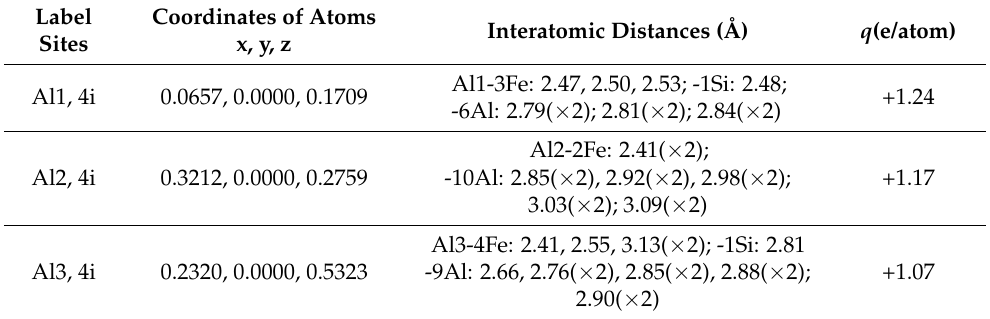
Figure 2. Schematic structure of θ -Al 68 Cu 2 Si 8 Fe 24 along its [010] projection ( a ). The schematic coordination of Cu ( b ) and Si ( c ) is shown, respectively. The pink lines in ( a ) represent a -axis (parallel) and c -axis (upwards) of the unit cell. Table 2. Calculated results for θ -Al 68 Cu 2 Si 8 Fe 24 . The space group is C2/m (nr. 12). The calculated lattice parameters are a = 15.390 Å, b = 7.910 Å, c = 12.309 Å, β = 108.06°.